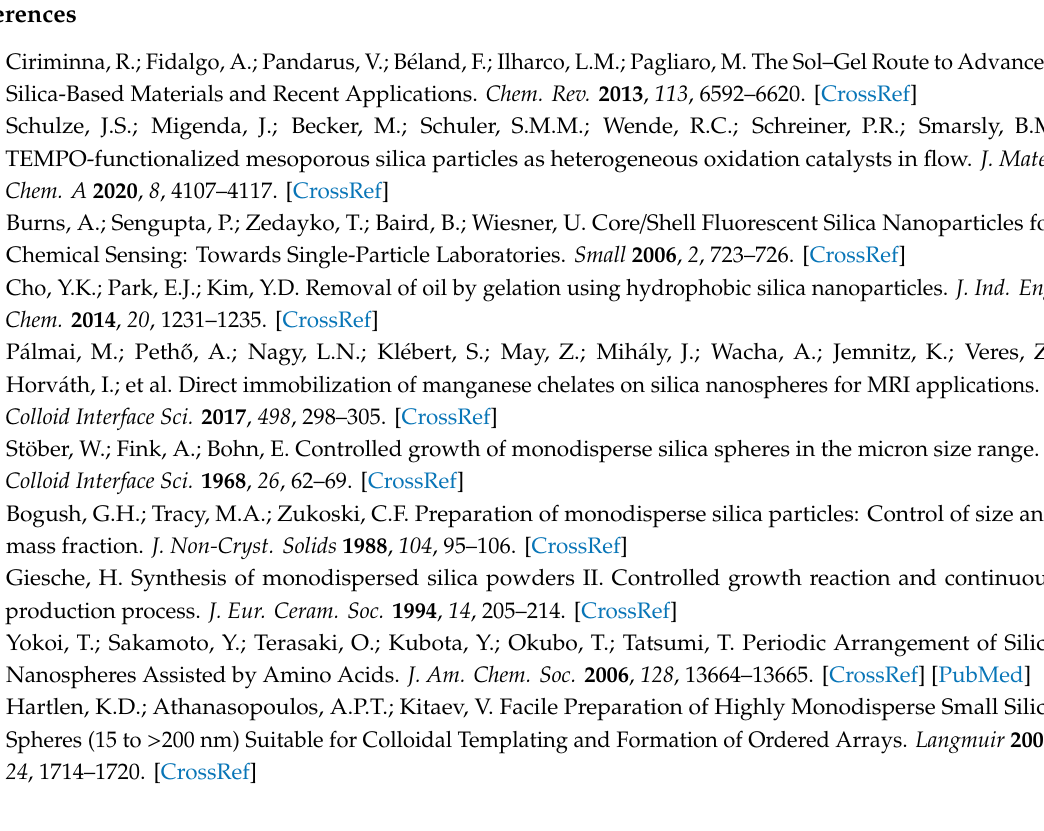
Figure S1: PSD as determined by TEM for the (a) M015, (b) M0171 and (c) SNP022 samples together with fitted Gaussian functions, Table S1: Mean diameters and full width at half maximum (FWHM) values of the number-weighted, volume-weighted and intensity-weighted particle PSDs obtained by DLS, Table S2: Results of fitting the SAXS curves with di ff erent model functions, Table S3: Results of fitting the SAXS curves with the bimodal log-normal distribution model for the SNP022 sample measured at a reduced and an extended q